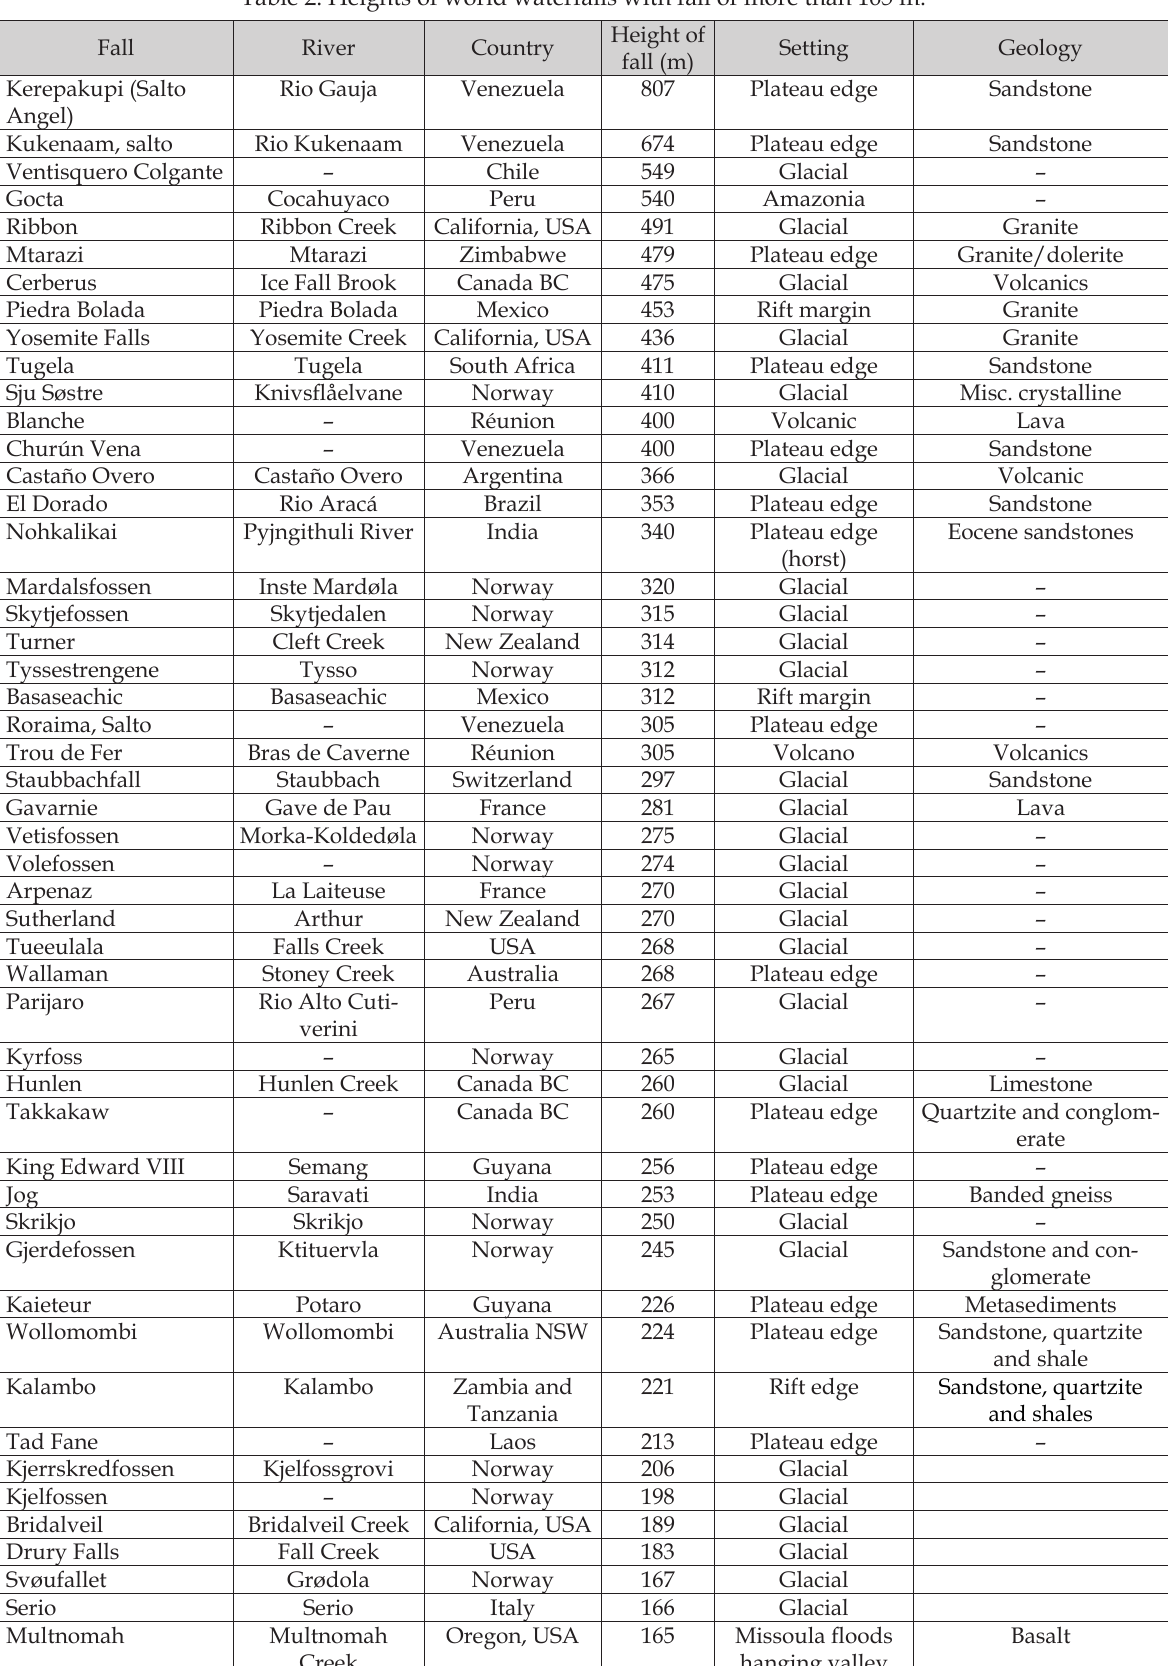
Table 2. Heights of world waterfalls with fall of more than 165